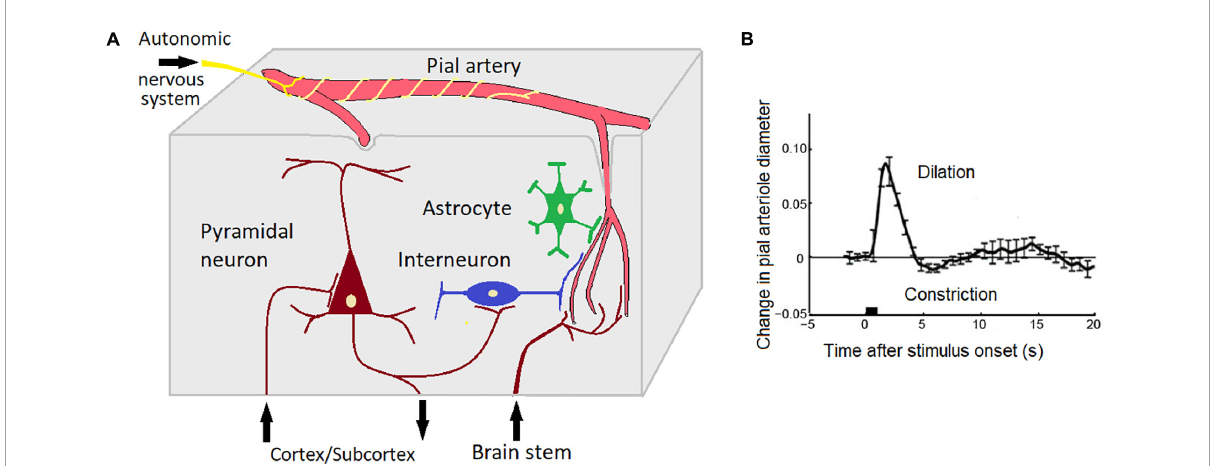
FIGURE5 Potential brain sources of EEG-ISF (see text for explanation). (A) A scheme depicting interactions between neuronal, glial, and vascular elements. Note that skin-related phenomena such as GSR and skin blood blow are not taken into account; (B) The effect of neuronal activity on the diameter of pial vessels as measured with two-photon laser scanning microscopy using a head-fixed rat. The stimulus is a 500 ms puff to the vibrissae. Adapted from Uhlirova et al. (2016). Note that a short sensory stimulation induces an oscillation (deletion, constriction) with a period of 10 s (0.1